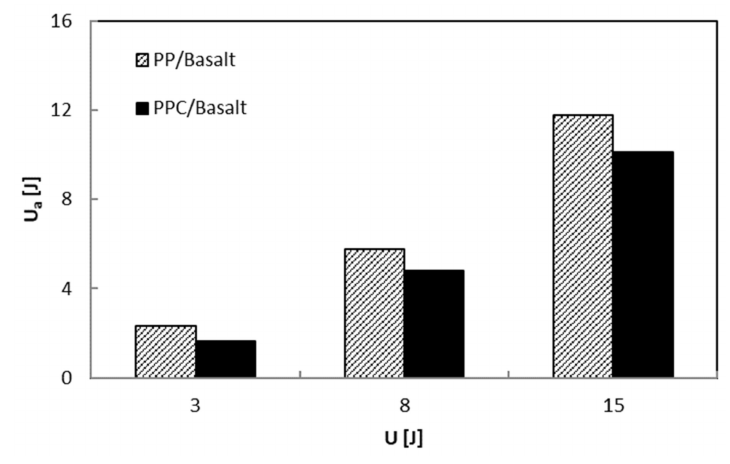
Figure 11. Absorbed energy, U a , versus impact energy, U.